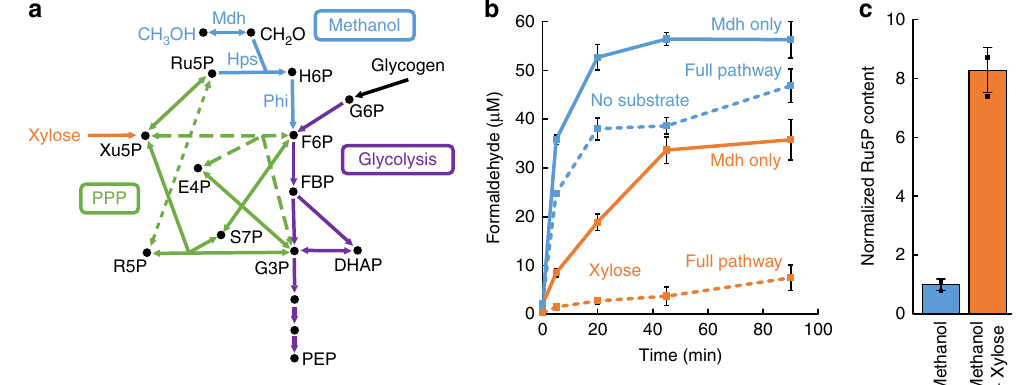
Fig. 2 Insuf fi cient Ru5P concentration in carbon-starved cells limits formaldehyde assimilation. a Detailed enzymatic reactions and metabolic pathways involved in methanol metabolism, showing the entry points of glycogen (the primary carbon source during starvation) through glycolysis, and xylose through the pentose phosphate pathway (PPP). Heterologous reactions unique to methanol assimilation are shown in blue. Glycolysis reactions are shown in purple, and PPP reactions in green. Dotted and dashed green lines added for clarity. b Formaldehyde levels over time after addition of 250 mM methanol to starved cells of E. coli MG1655(DE3) Δ frmA with either no additional substrate (blue) or 6 g L − 1 xylose (orange). Solid lines represent cells expressing only Mdh, and dashed lines denote cells expressing the full methanol assimilation pathway (Mdh, Hps, and Phi). c Relative ribulose 5-phosphate (Ru5P) concentration in cells with no substrate or xylose. Error bars represent s.d. of n = 3 biological replicates (three individual colonies). H6P: D -arabino-3- hexulo-6-phosphate, F6P: fructose 6-phosphate, G6P: glucose 6-phosphate, FBP: fructose 1,6-bisphosphate, DHAP: dihydroxyacetone phosphate, G3P: glyceraldehyde 3-phosphate, PEP: phosphoenolpyruvate, E4P: erythrose 4-phosphate, S7P: sedoheptulose 7-phosphate, R5P: ribose 5-phosphate, Ru5P: ribulose 5-phosphate, Xu5P: xylulose 5-phosphate